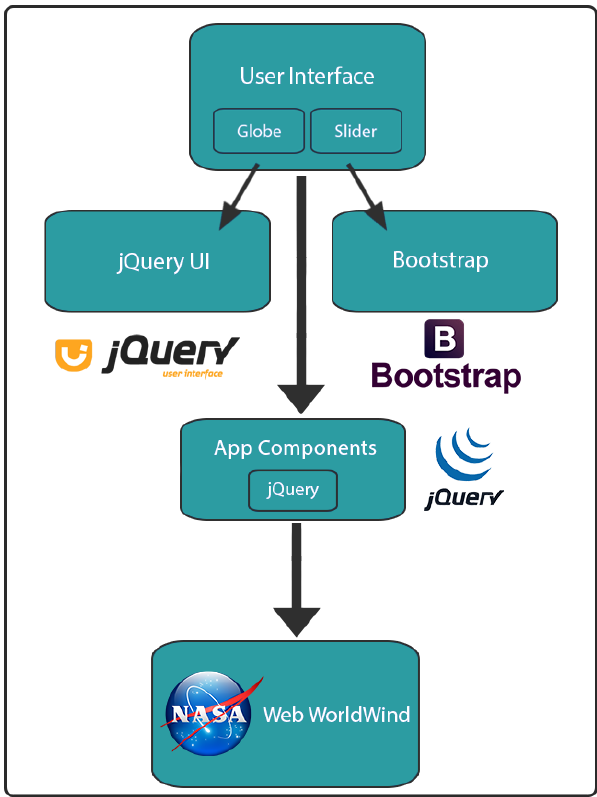
Figure 4. Application Architecture